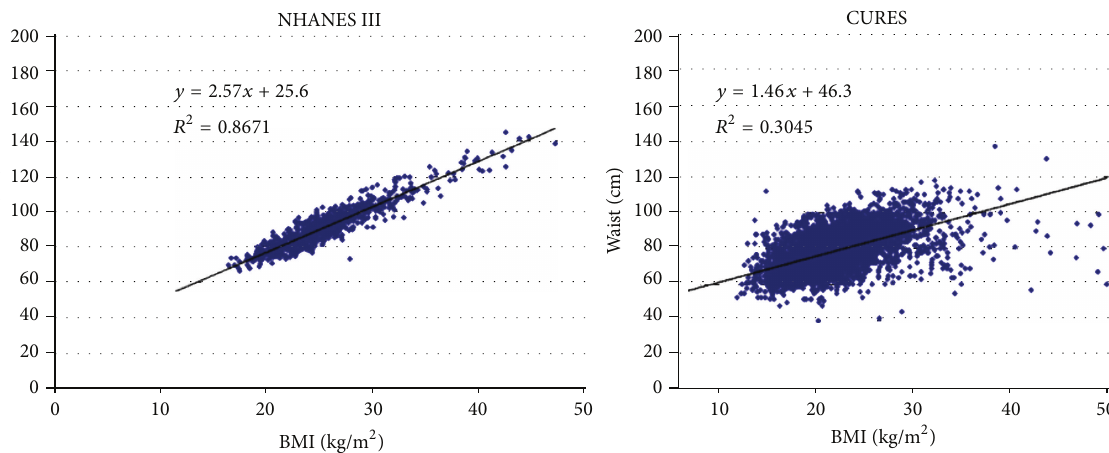
Figure 3: Correlations of waist circumference and BMI in US Caucasian and Asian Indian men. The corresponding 𝑅 2 value for women of NHANES III was 0.85, in comparison to 0.31 for CURES women. The 𝑅 2 across the other two NHANES III race/ethnic groups for men and women ranged from 0.81 to